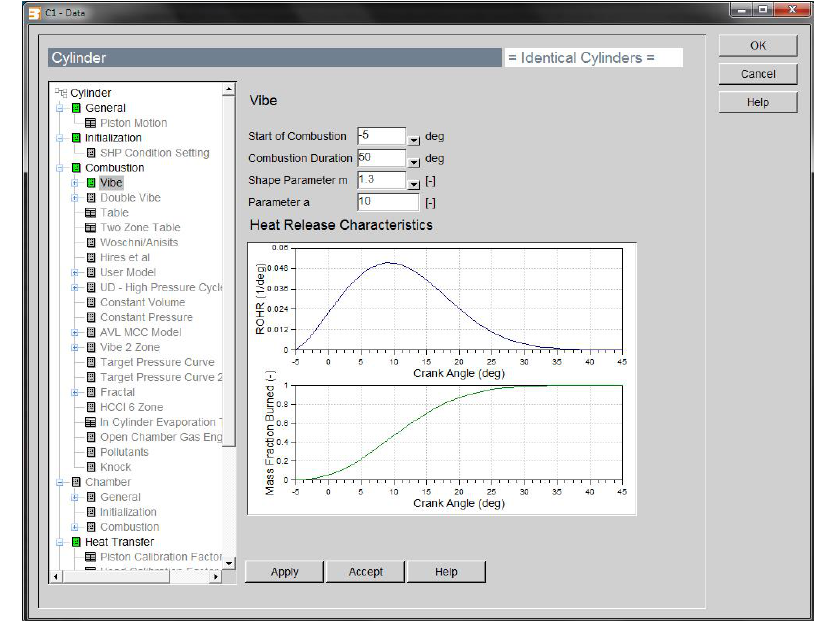
Figure 6. Engine burning model - Vibe function was used. Parameters ” m ” and ” a ” are shape parameters.